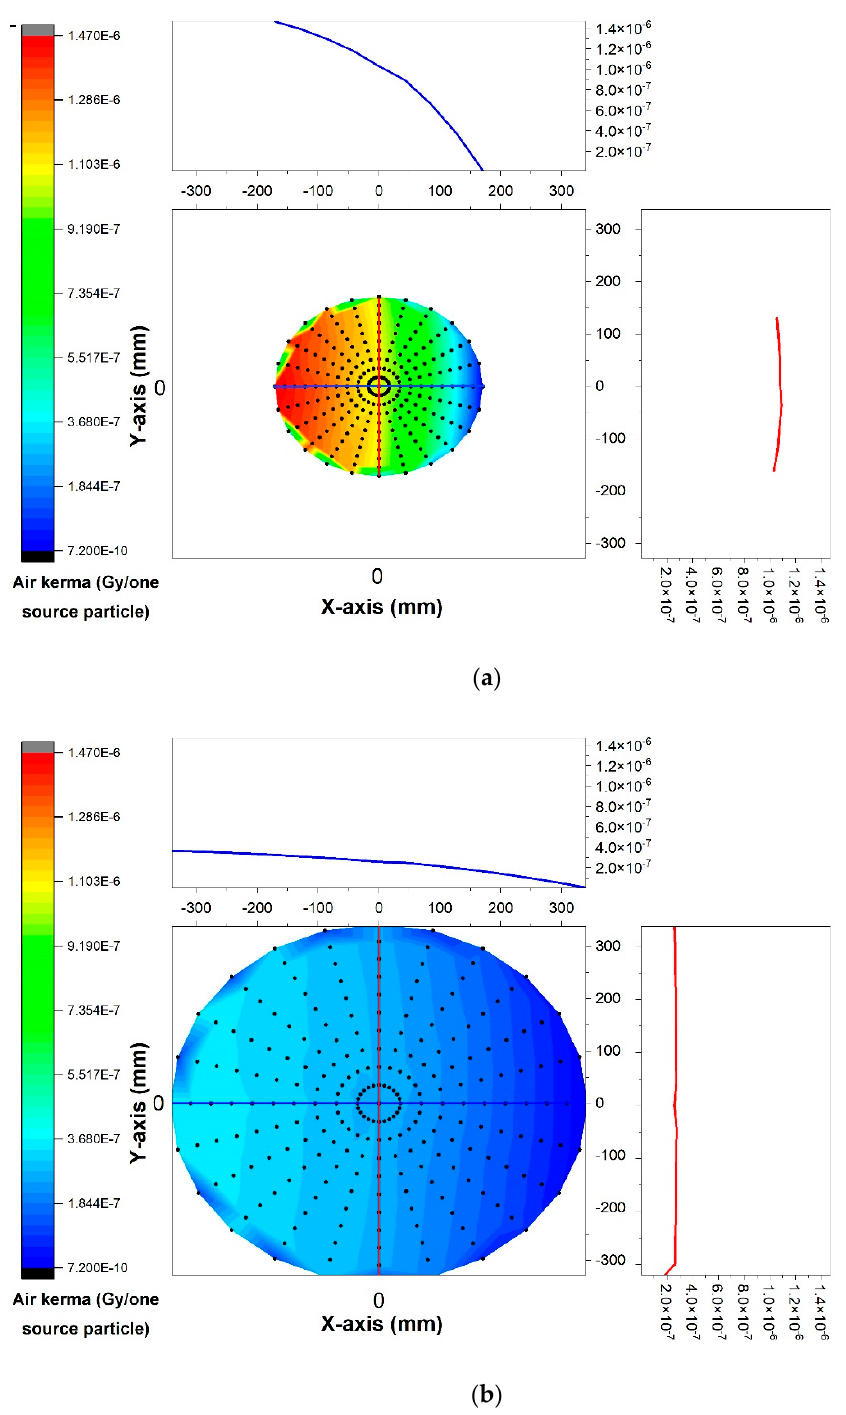
Figure 3. Calculated air kerma when tube voltage was maintained at a value of 80 kV and detectors were positioned at distances of ( a ) 500 mm and ( b ) 1000 mm.